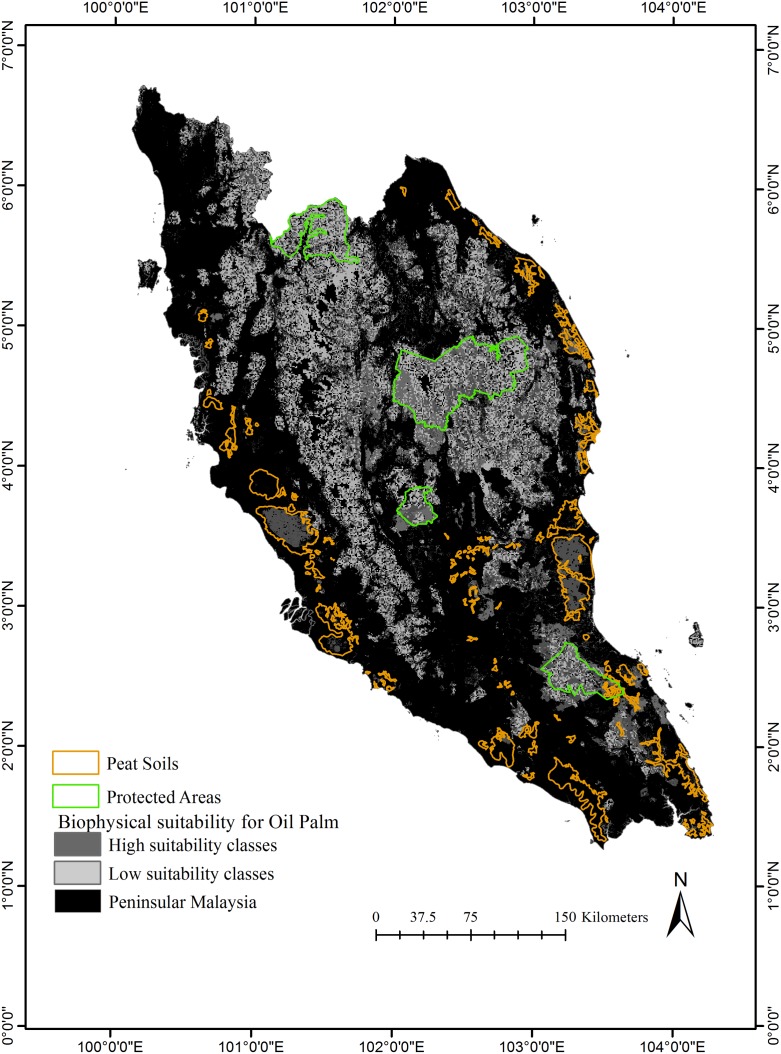
Remaining natural forests (2014) within high and low suitability classes for oil palm, protected areas from the World Database on Protected Areas (WDPA) [52] and on peat soils [53].